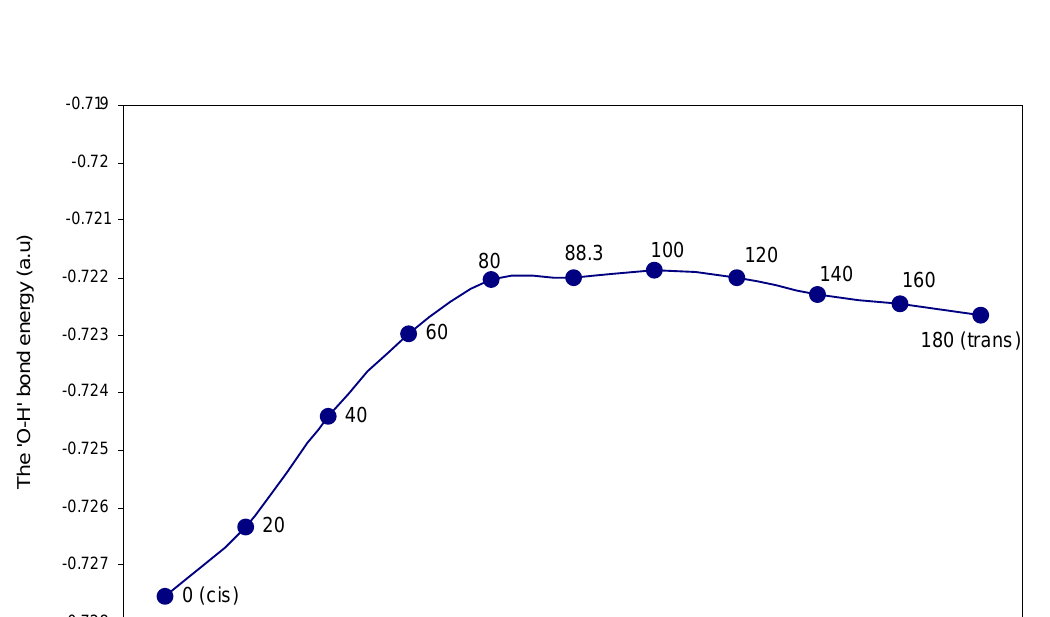
Figure 4. Plot of total 'O-H' bond energy of Hydrogen Peroxide as a function of torsional